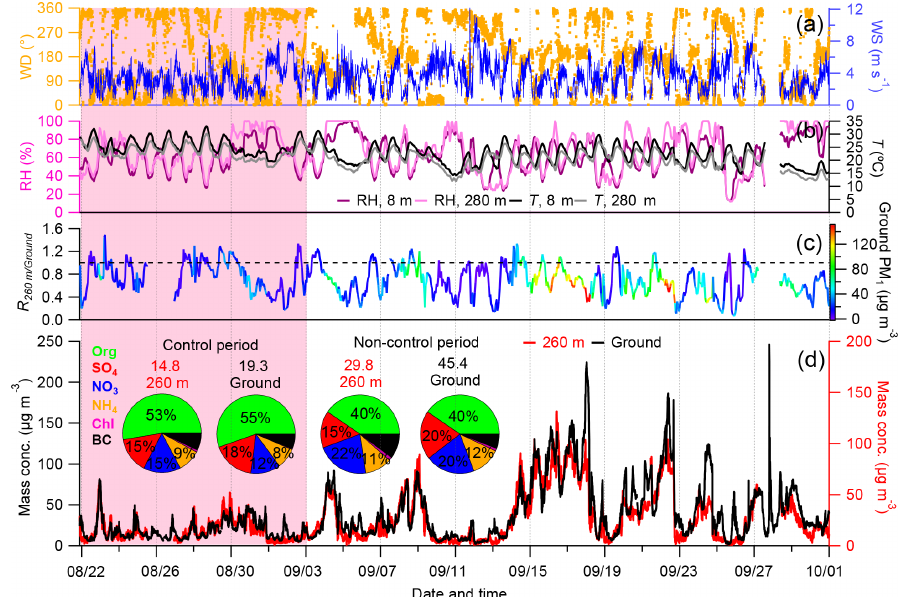
Figure 2. Time series of (a) wind direction (WD) and wind speed (WS) at 280m, (b) relative humidity (RH) and temperature ( T ), (c) ratio of 260m to ground for PM 1 and (d) PM 1 mass concentrations at 260m and ground. The pie charts depict the average chemical composition during and after the control period at 260m and the ground site,